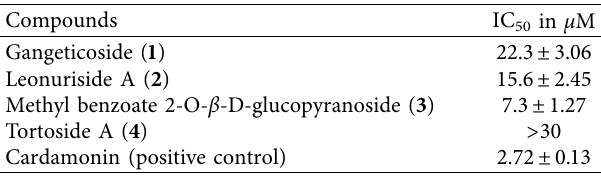
Figure 2: Key HMBC, and NOESY correlations of the new compound 1 . Table 1: Inhibitory activity of NO production of compounds 1 - 4